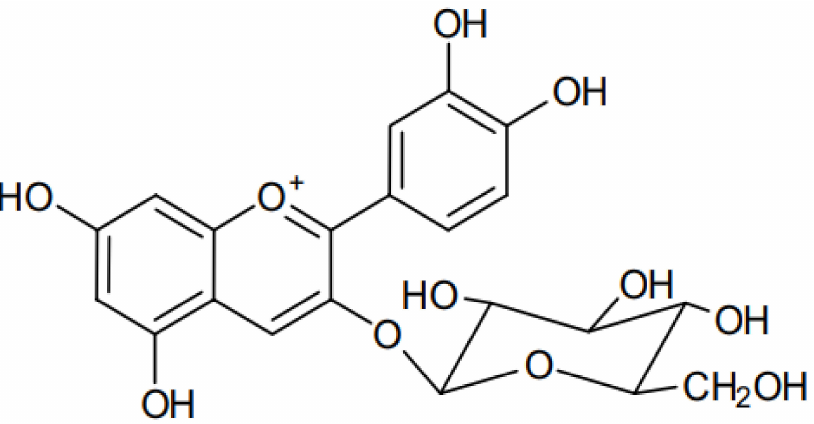
Figure 1. Chemical structure of cyanidin 3- O